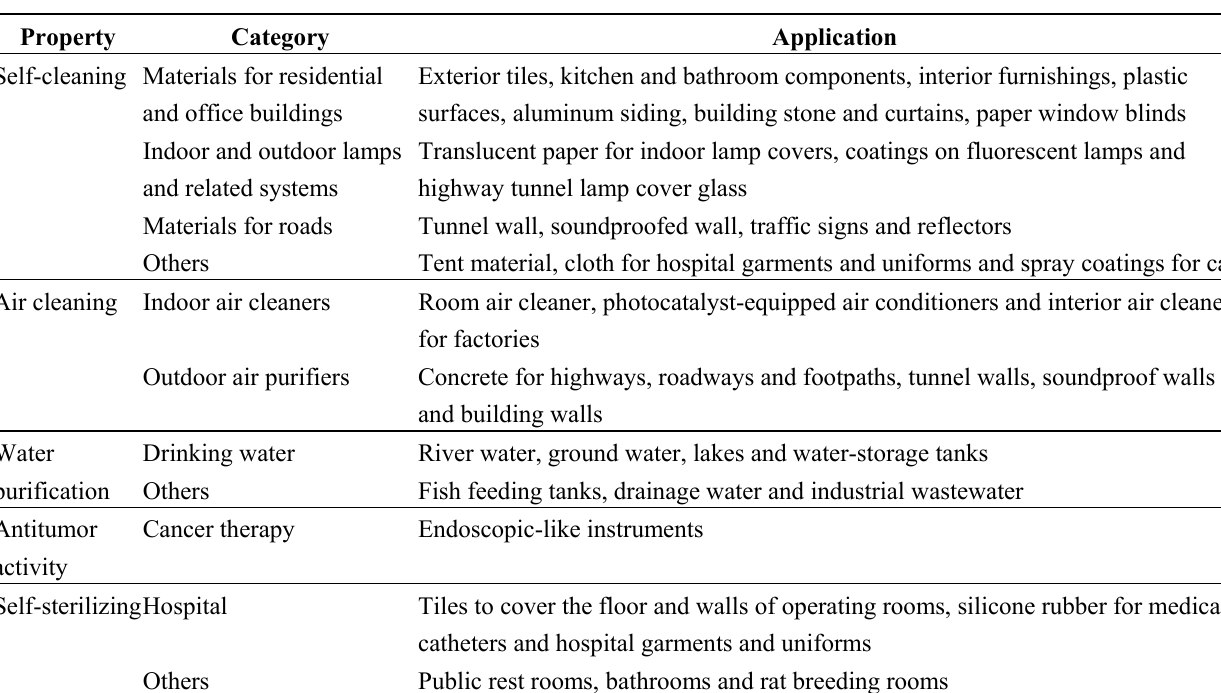
Table 1. Selected applications of photocatalysis. Note: this Table is reproduced with permission from [92], Copyright © 2000 Elsevier Science